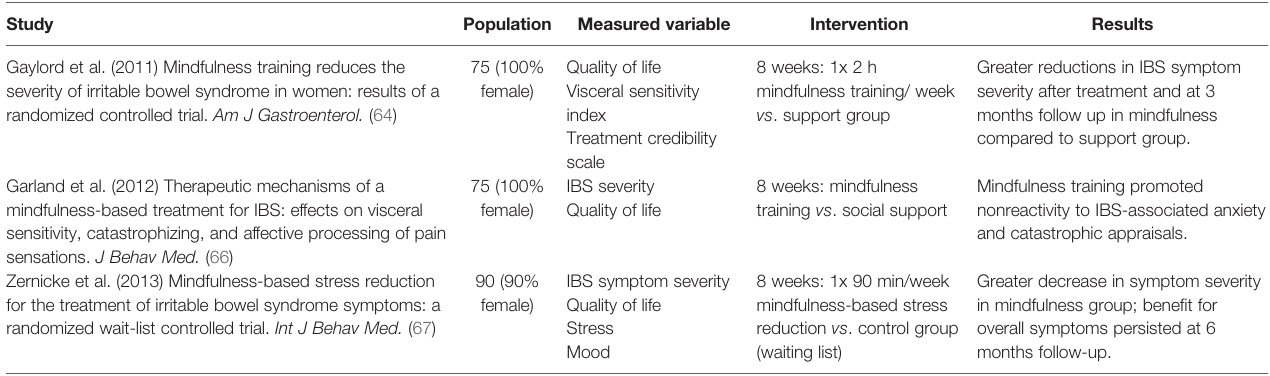
TABLE 6 | Randomized controlled studies investigating the effects of mindfulness-based therapy in patients with irritable bowel